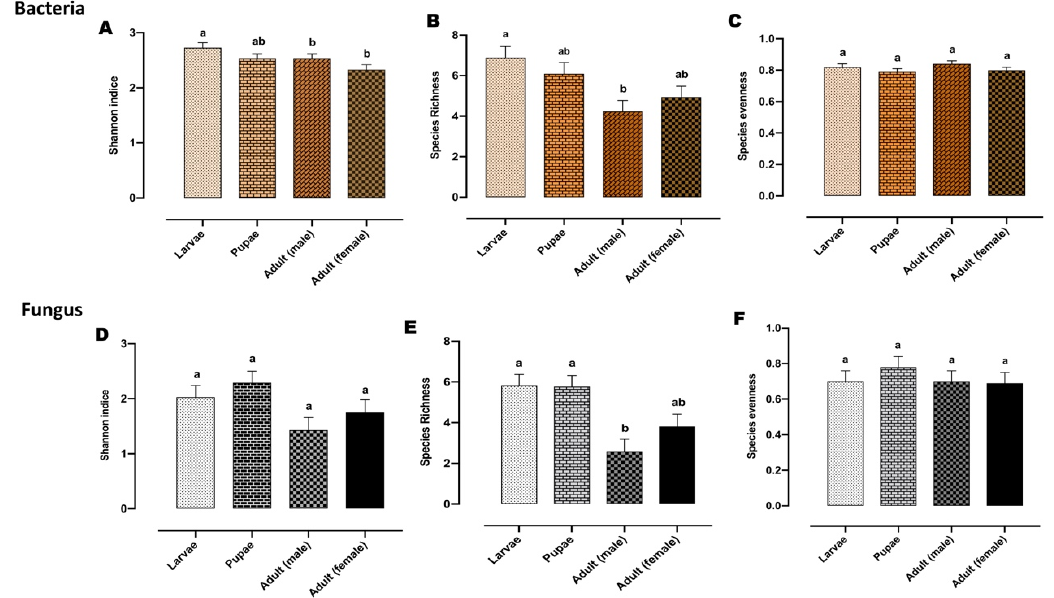
Figure 2. Alpha diversity of the bacterial and fungal microbiome of the Qfly developmental stages includes ( A ) Shannon indices, ( B ) species richness, and ( C ) species evenness of the bacterial microbiome. ( D ) Shannon indices, ( E ) species richness, and ( F ) species evenness of the fungal microbiome. Different letters indicate significant Tukey’s post hoc comparisons ( p < 0.05).